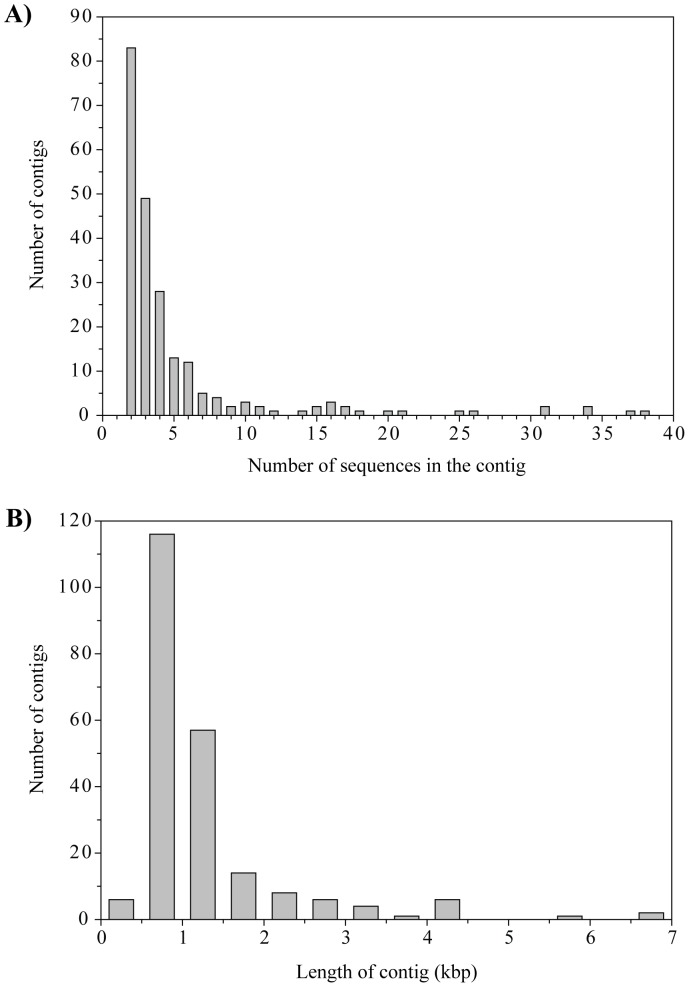
Contig spectrum and length distribution of contigs assembled from the sequence library.(A) Histogram of the number of sequences in each contig assembled with Sequencher using conditions of 98% minimum match and >20 bp overlap. (B) Histogram of the lengths of those contigs.